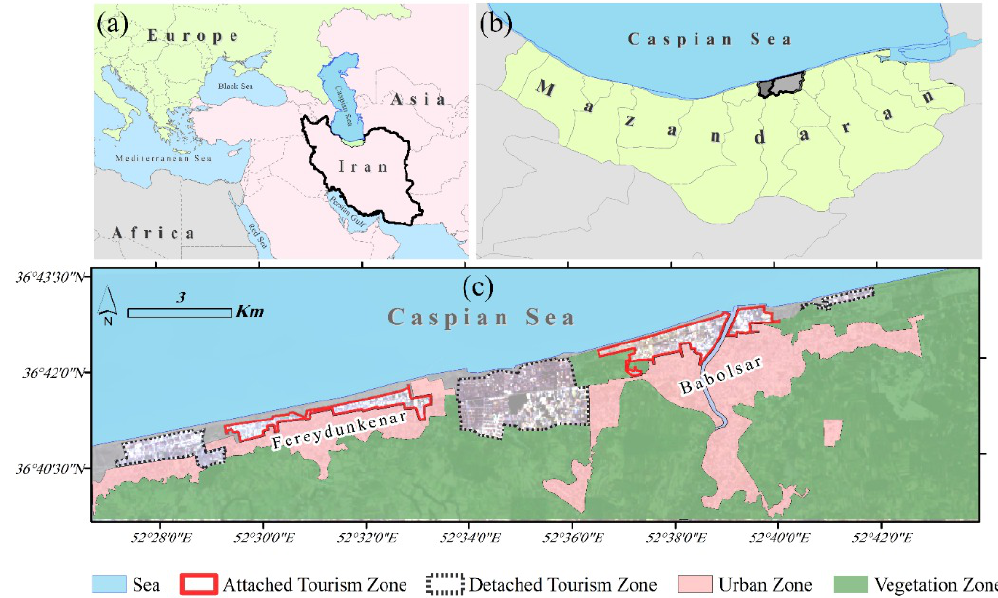
Figure 1. The study area in Iran ( a ) and Mazandaran Province ( b ) and the main land use/cover zones ( c